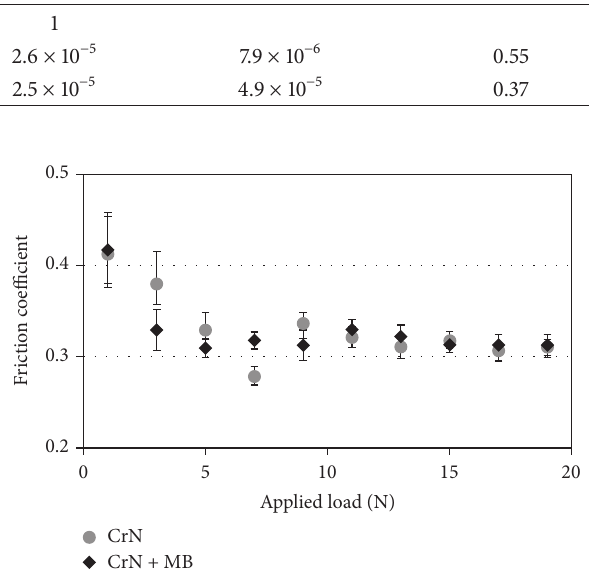
Figure5:Frictioncoefficientasafunctionoftheappliedload(100 m